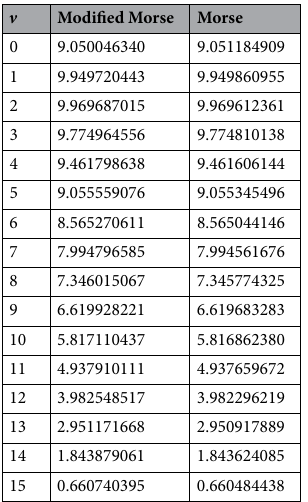
Table 4. Comparison of the energy eigenvalues (in eV) of the modified Tietz–Hua and actual Tietz–Hua potentials with a = (cid:31) = µ = 1, r e = 0.5 Å, b h = 0.55 Å, b = 0.001 Å, C h = 0.95 and D e = 10 eV